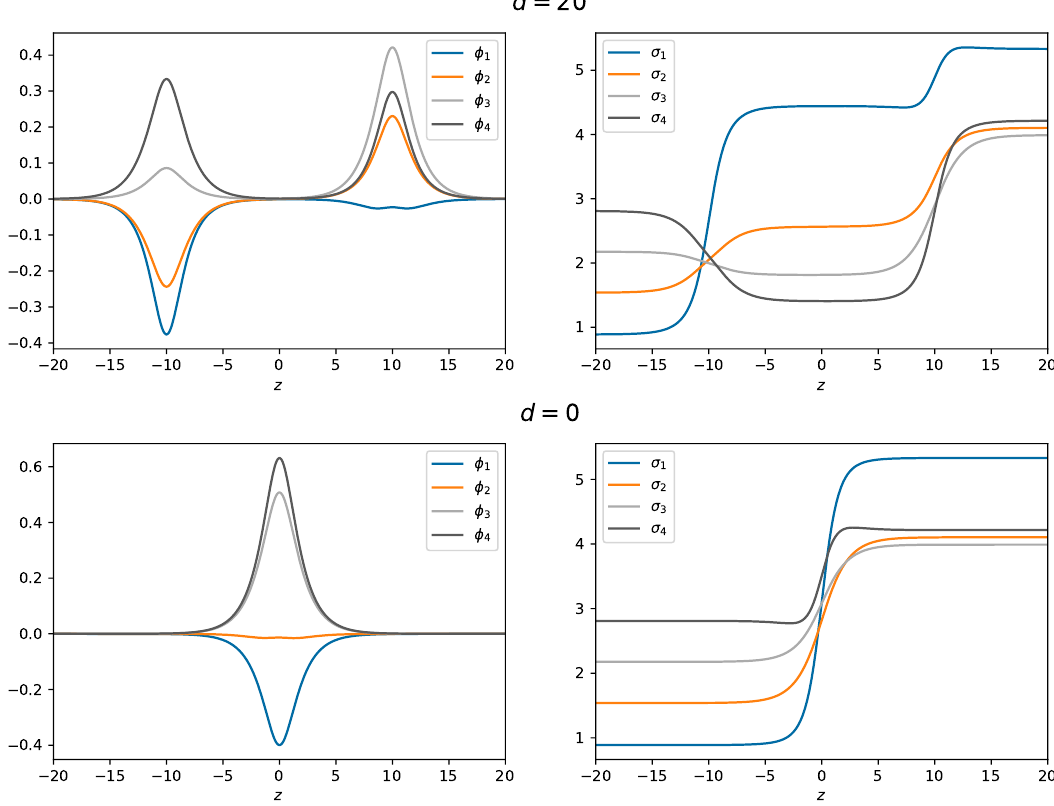
Figure 16. The sum of two BPS 1-walls for N = 5 and N -ality k = 1 , taken at two different kink separations d = 20 and d = 0 . The 1-wall situated to the left of the origin has flux Φ 1 ,I 2 π ρ /N − 2 π w k , and the 1-wall to the right has flux Φ 1 ,II = 2 π ρ /N . The corresponding boundary values for the σ field are 2 π ρ /N at z = −∞ and 2 π ρ /N + 2 π w 1 at z = ∞ .